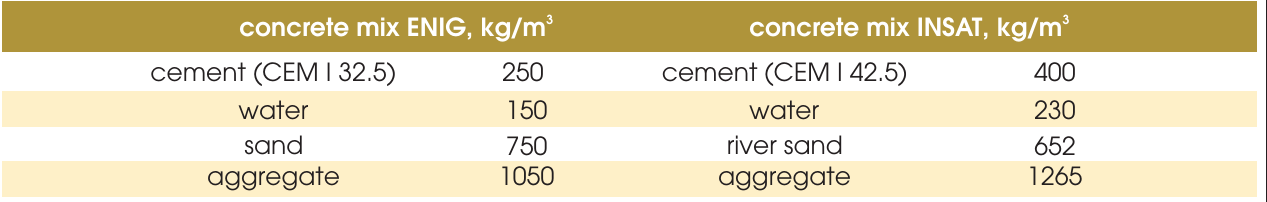
Table 1 – Concrete mixes used in the studies at ENIG and INSA